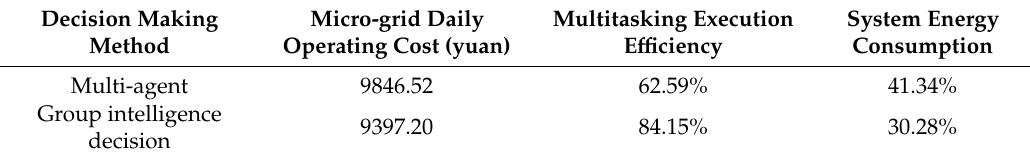
Table 7. Optimization parameters under the group intelligent decision-making